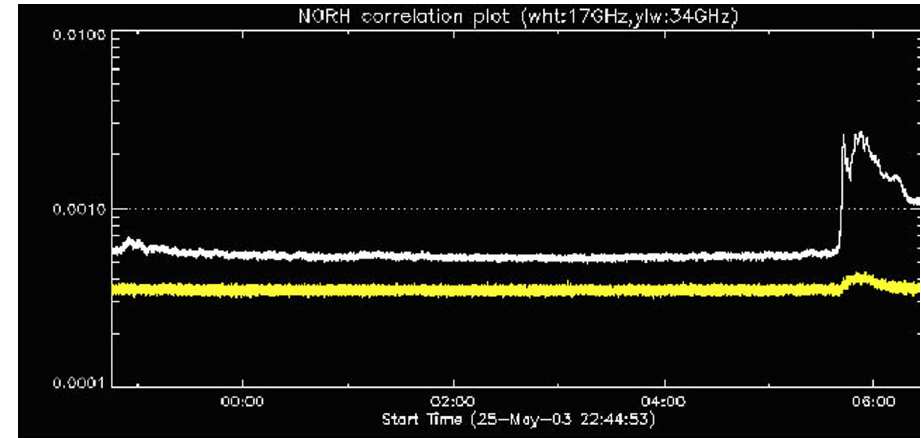
Figure 3: NoRH 17 – 34 GHz plot ( 25 – 26 May 2003 ) ( from Nobeyama RadioHeliograph Team )